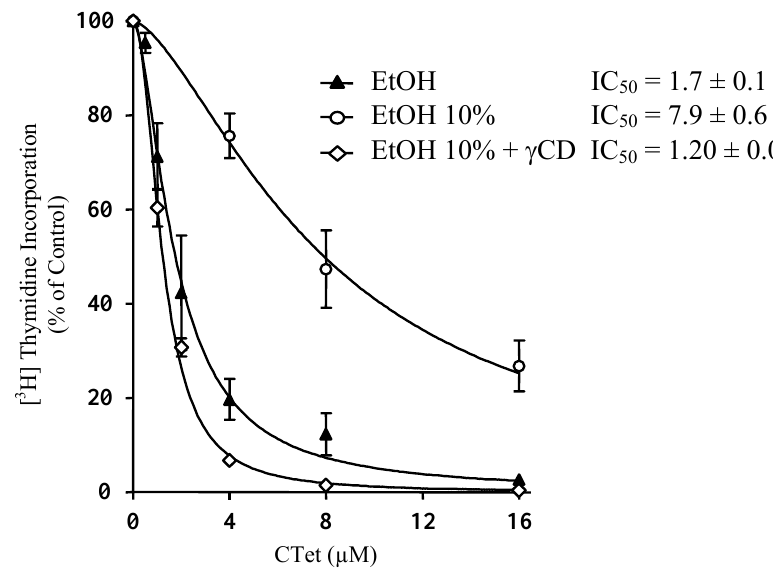
Figure 2. Effect of CTet formulated in aqueous solutions on DNA synthesis of MCF-7 breast cancer cell line. Cells were treated with various concentrations of CTet suspended in 10% EtOH ( (cid:123) ), 10% EtOH with 160 mM γ -CD ( ◊ ) or pure EtOH ( ▲ ); during the last 5 h of treatment, cells were pulsed with [ 3 H]thymidine, and the incorporation into DNA was determined (1.5 μ Ci). Data are expressed as percentage of cells treated with vehicle only and are means ± SEM of at least three